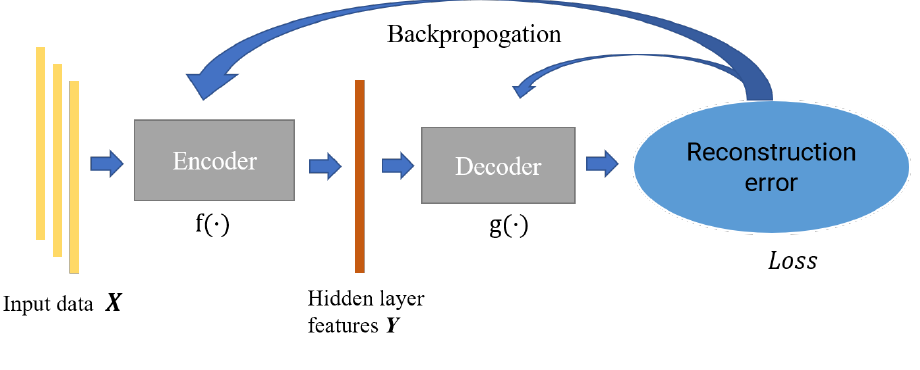
Figure 3. The structure of